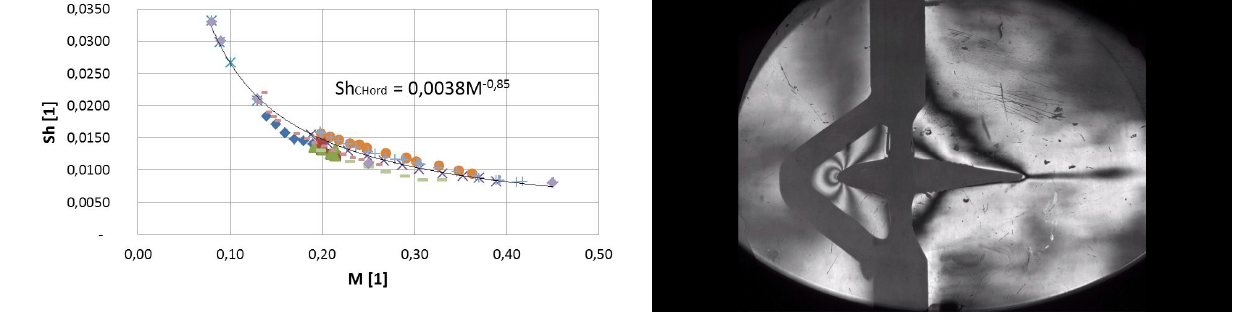
Fig. 13a. Interferogram, airfoil at bottom dead centre.